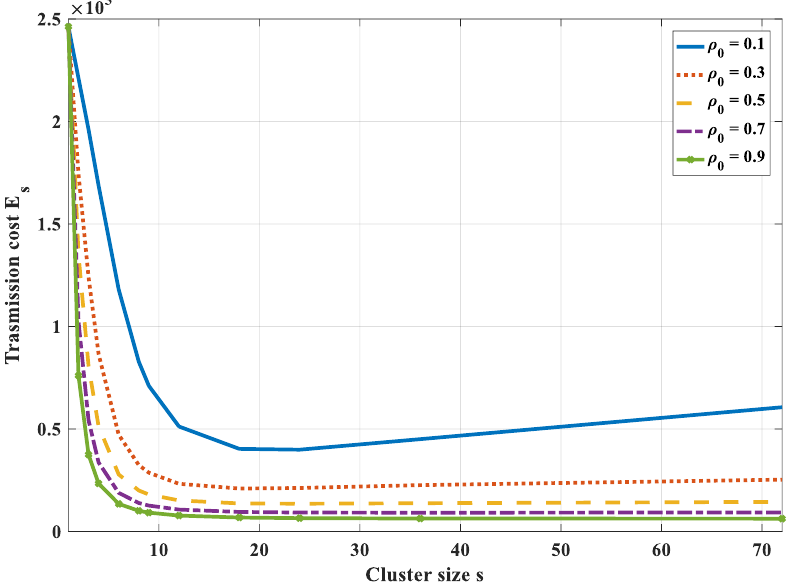
Figure 13. Total bit-hop cost E s , respectively, to cluster size with different values of entropy correlation coefficient in the case of 2-D with compression along SPT to the cluster head.